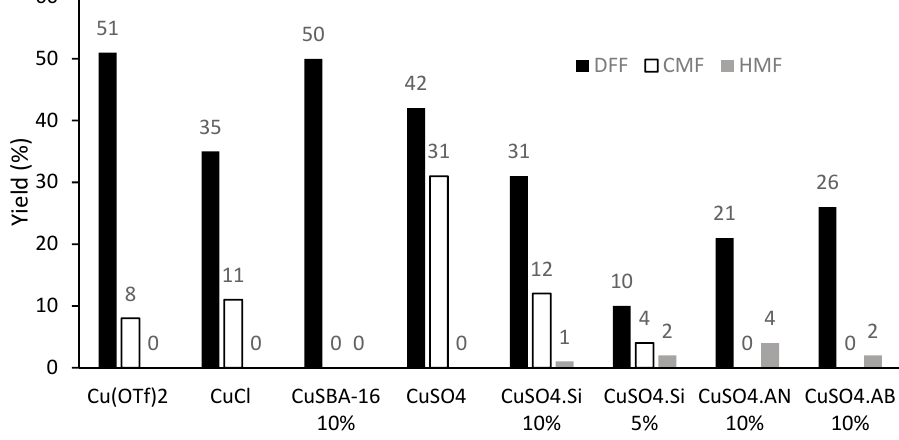
Figure 4. Effect of the promoter nature on the oxidation of CMF under microwave irradiation (MWI). Reaction conditions : CMF (0.35 mmol, 50 mg), catalyst, PNO (4 equiv.) in CH 3 CN (0.5 M) and 160 °C for 5 min under MWI; yields were determined by 1 H-NMR analysis of the crude reaction mixture using 1,3,5-trimethoxybenzene as an internal standard.